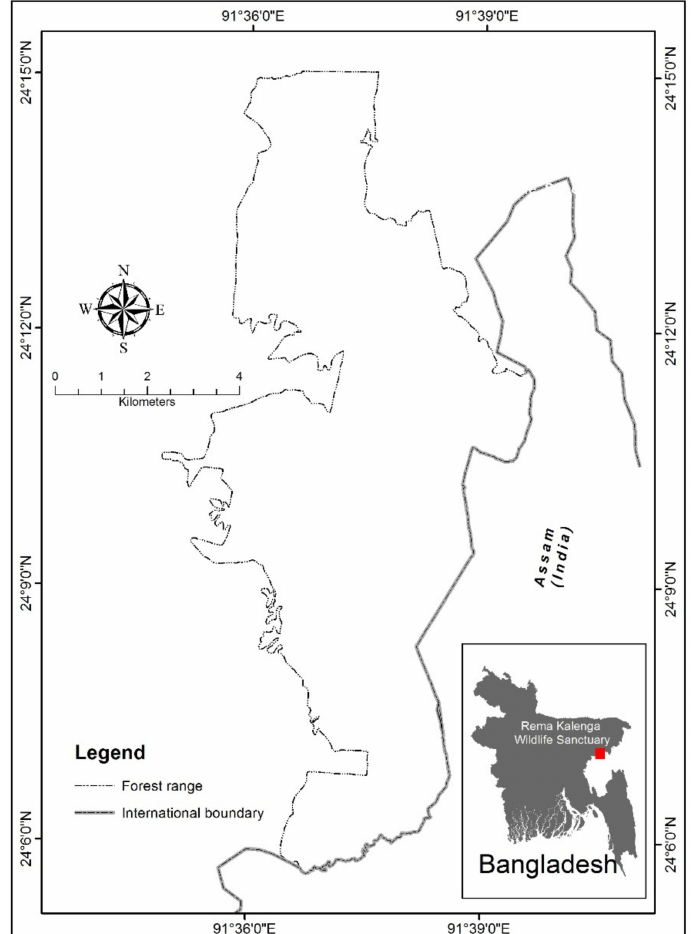
Figure 2. Location of the Rema-Kalenga Wildlife Sanctuary (RKWS), as a protected area in Bangladesh. RKWS consists of forest reserve areas and wildlife sanctuary